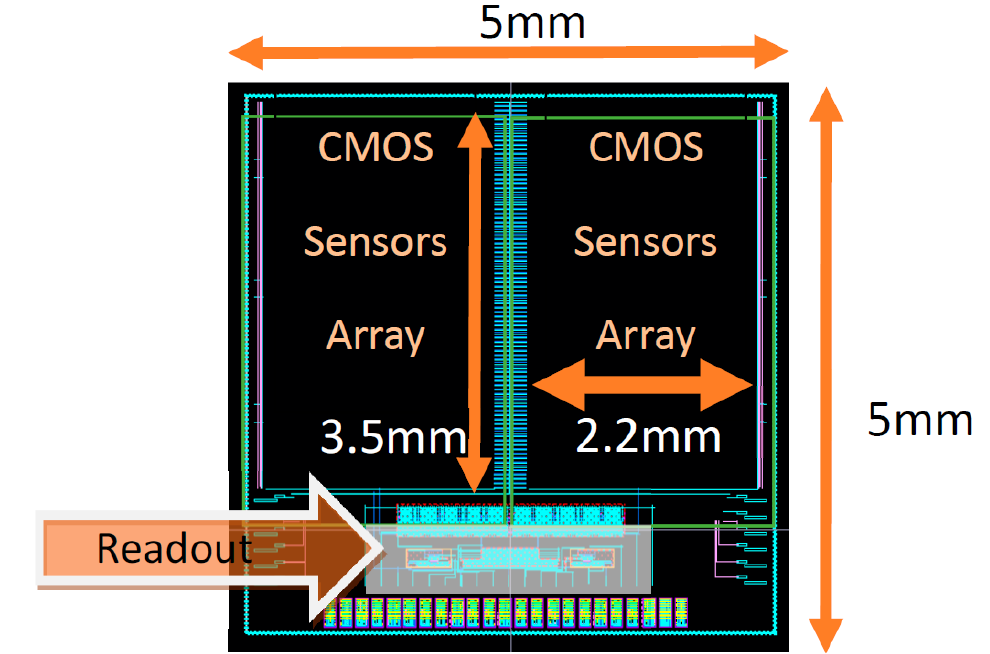
Figure 5. CMOS Sensor device layout.